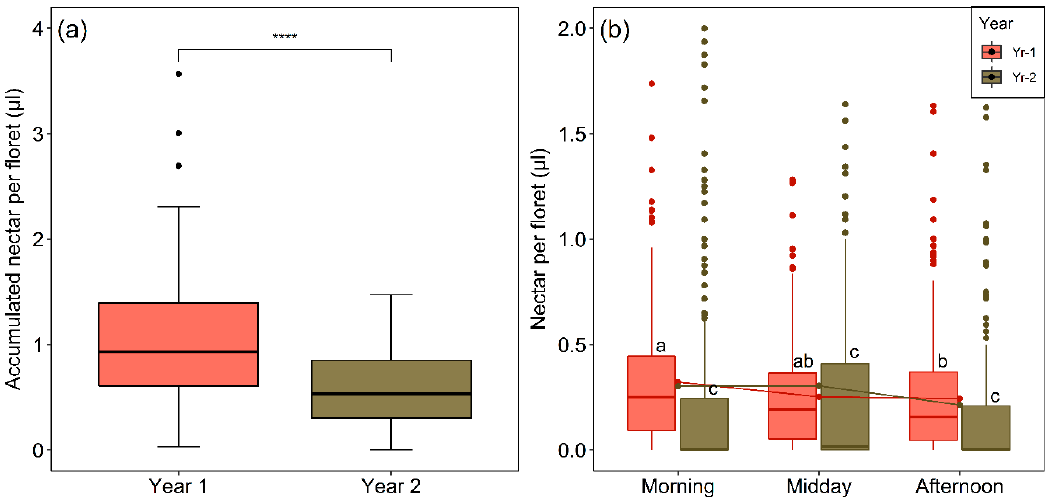
Table 3. Results of nonparametric factorial analysis (aligned ranks transforms) for nectar standing crop in M. subulata over the last two years of the Chilean mega drought. Significant effects are shown in bold.